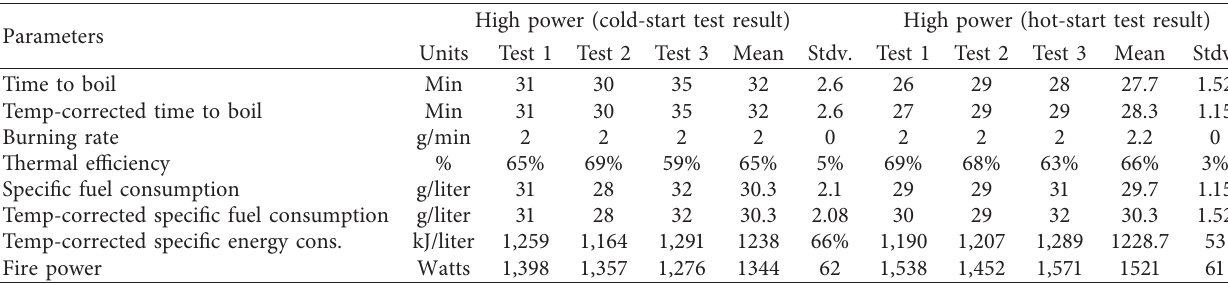
Table 6: Performance of the Jatrok stove using J10